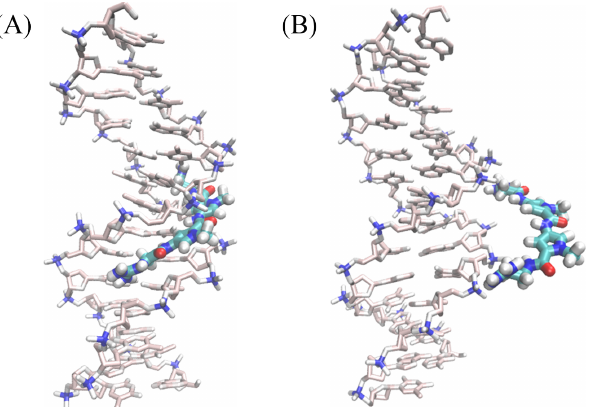
Figure 4. Snapshots extracted from the separation simulations for the double-well shape. ( A ) the representative structure near the first minimum; ( B ) the representative structure near the second